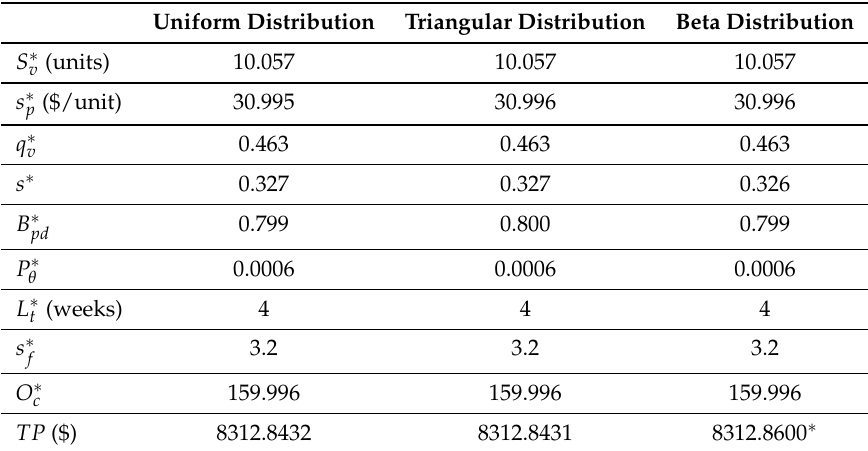
Table 4. Optimum Values with Service Constraint.